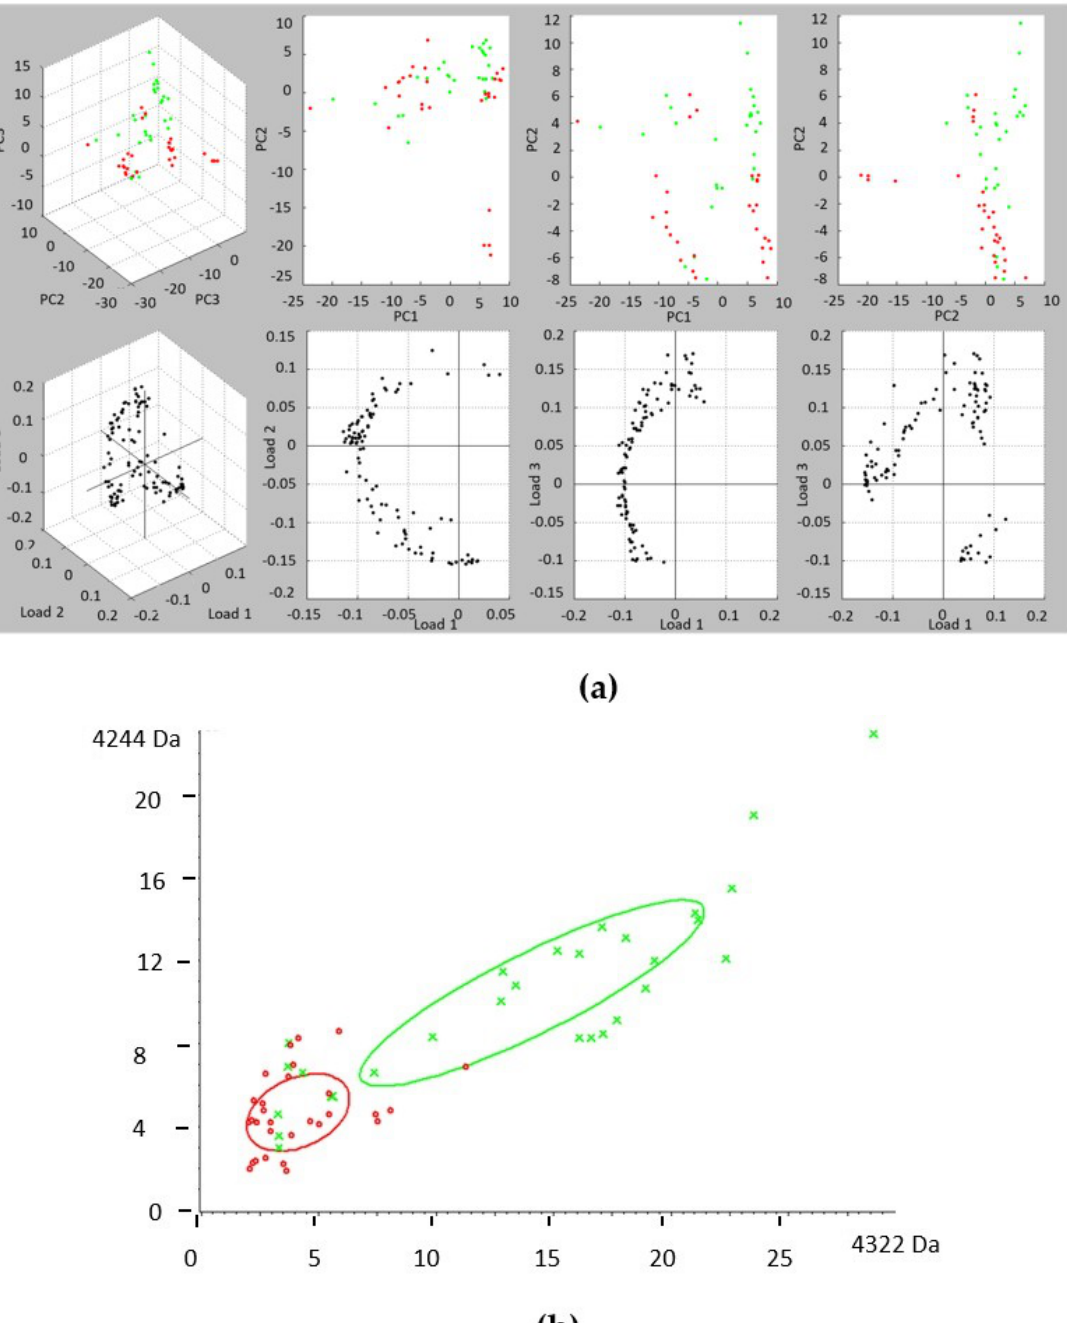
Figure 3. ( a ) PCA analysis contrasting spectral data of mature milks from NW (green) and OW/Ob (red) subjects. 3D view and combinations of the first three principal components. ( b ) 2D-plot protein spectra according to the intensities of m / z 4244 and 4322. Number of points = 54 (9 NW subjects, 9 OW/Ob subjects, 3